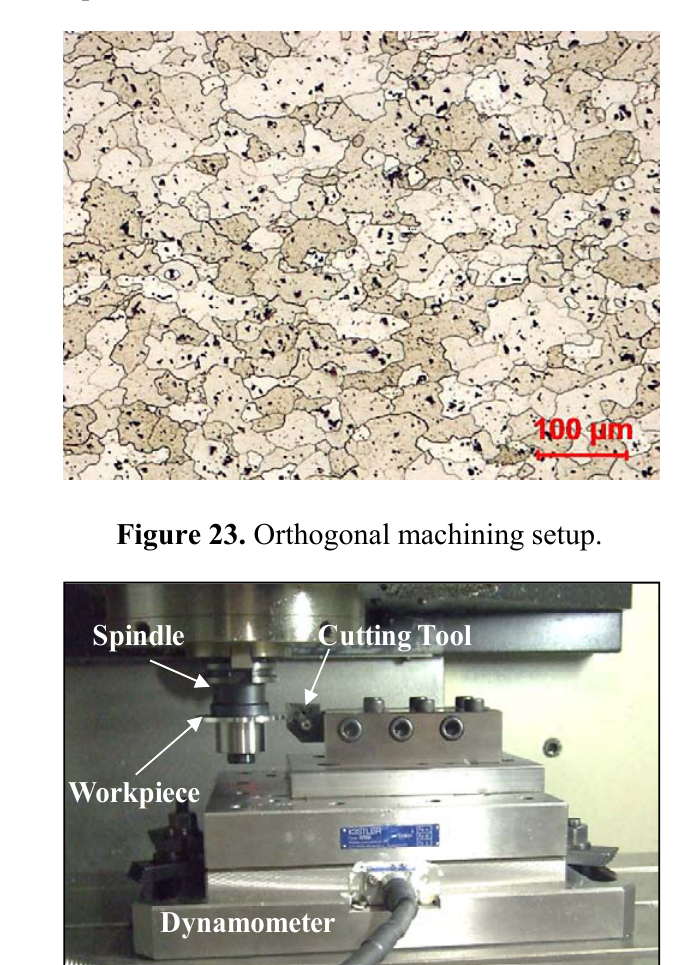
Figure 22. Optical microstructure of the aluminum AA7075-T651 alloy.